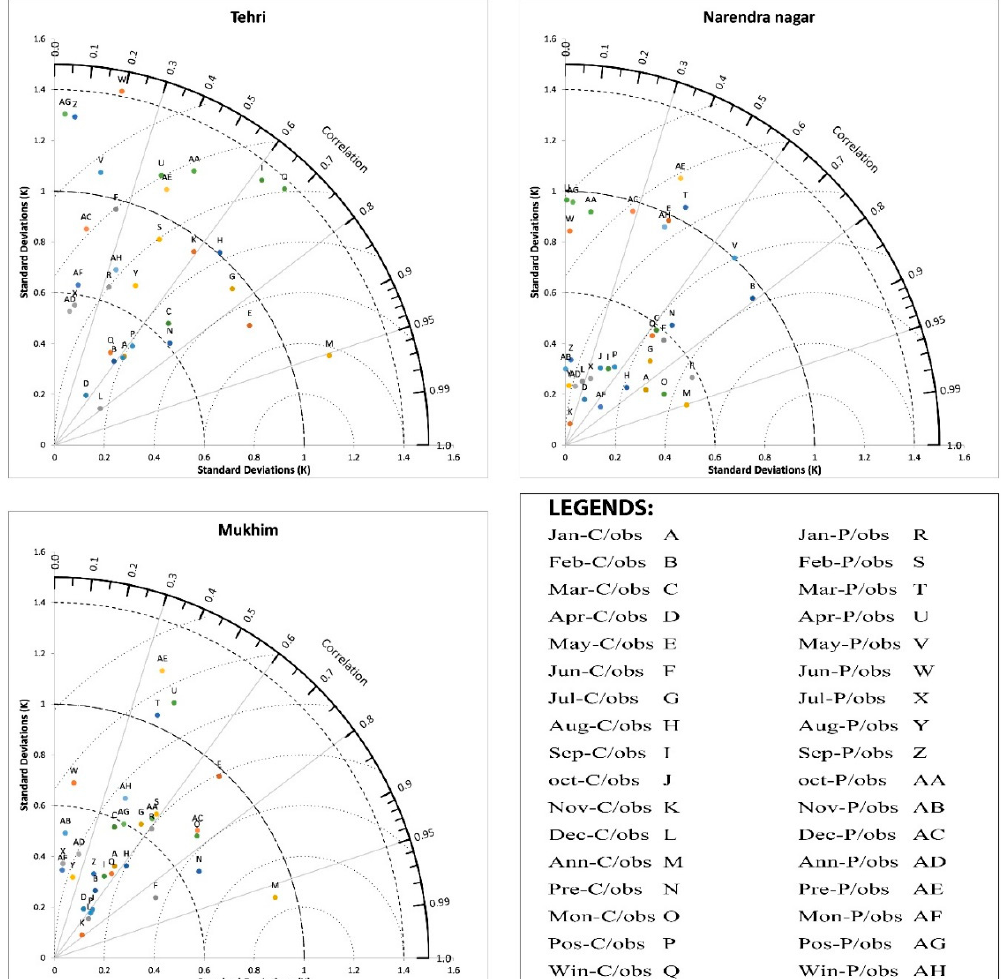
Figure 9. Taylor diagram compares observed and gridded datasets (Notations, “Jan to Dec” are used for defining months, “Ann to Win” for annual and seasons, “obs” for the observation stations and “C” and “P” denote CHIRPS and PERSIANN-CDR respectively).